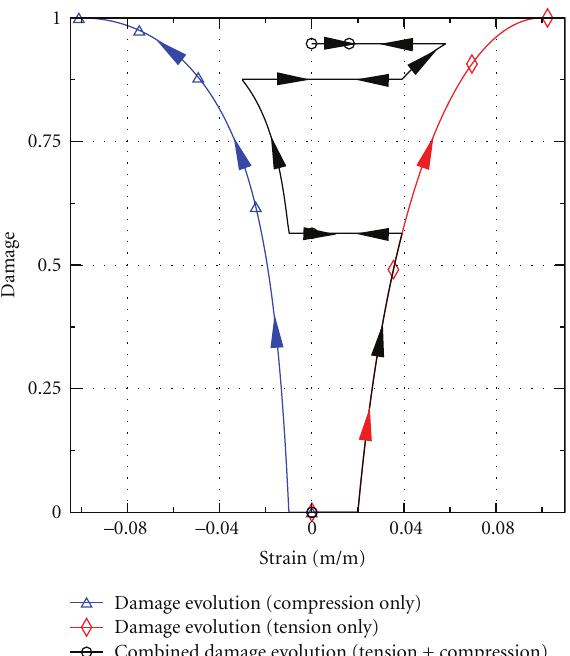
Figure 10: Damage evolution law due to combined tension and compression loading in the fibre